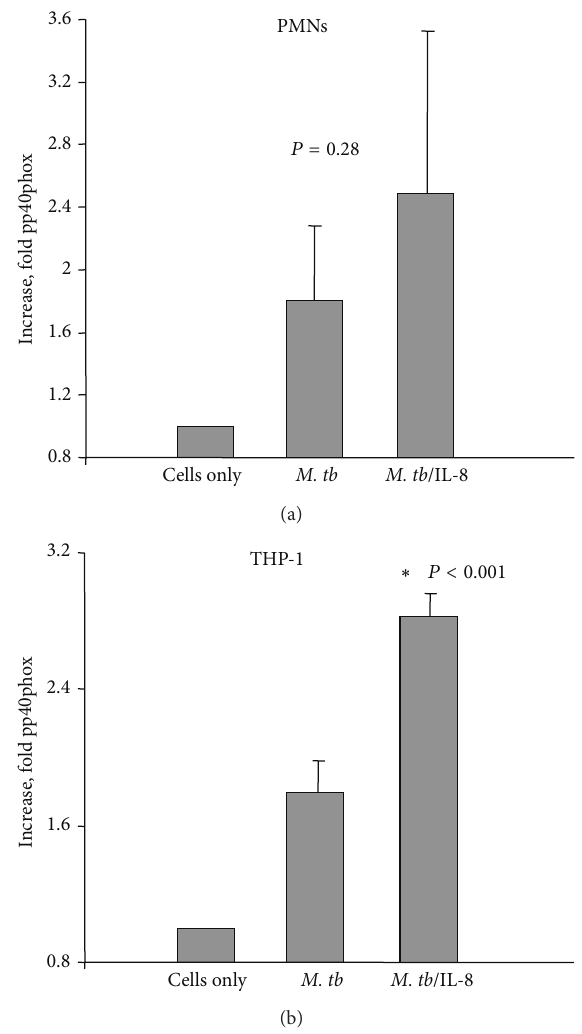
Figure 5: Respiratory burst presented as a level of pp40phox component detected using fluorescent microscopy. (a) Level of pp40phox molecule in neutrophils infected with M. tb cytokine-free ( M. tb ) or M. tb associated with IL-8 ( M. tb /IL-8) presented as an intensity scan/increase fold over normal cells. (b) Level of pp40phox molecule in THP-1 cells infected with M. tb cytokine-free ( M. tb ) or M. tb associated with IL-8 ( M. tb /IL-8) presented as an intensity scan/increase fold over normal cells.